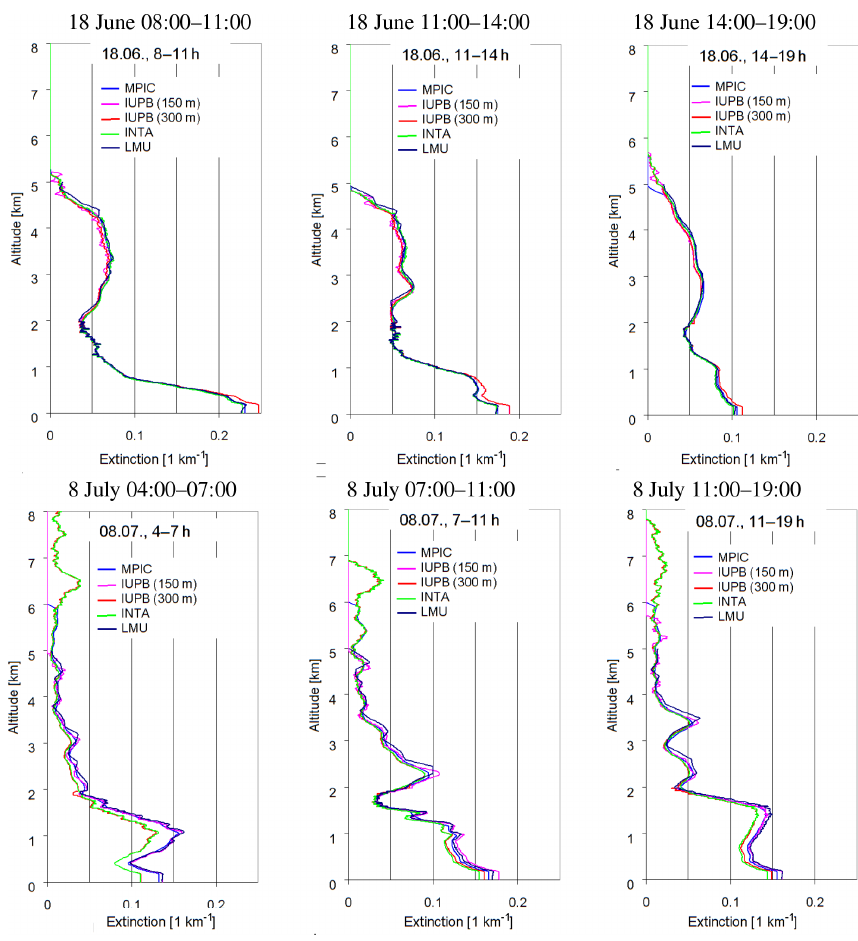
Figure 9. Comparison of the aerosol extinction profiles extracted by the different groups for all three periods on both days.